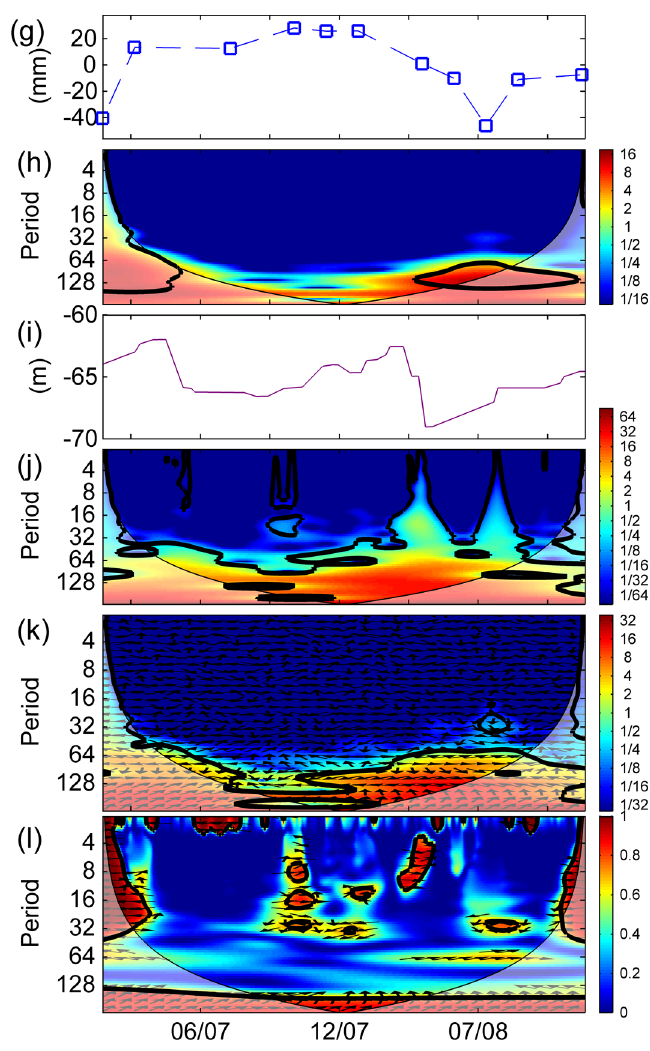
Figure A1. ( a ) Detrend of Envisat time series at JH-12 Well; ( b ) continuous wavelet power of the Envisat time series; ( c ) water level of JH-12 Well; ( d ) continuous wavelet power of water level time series; ( e ) cross wavelet transform of Envisat and water level time series at JH-12 Well; and ( f ) wavelet coherence of Envisat and water level time series for JH-12. Images ( g – l ) are the same for ALOS and water level time series at JH-12 Well. The thick contour is the 95% confidence level. The cone of influence (COI) is shown in light shadow.